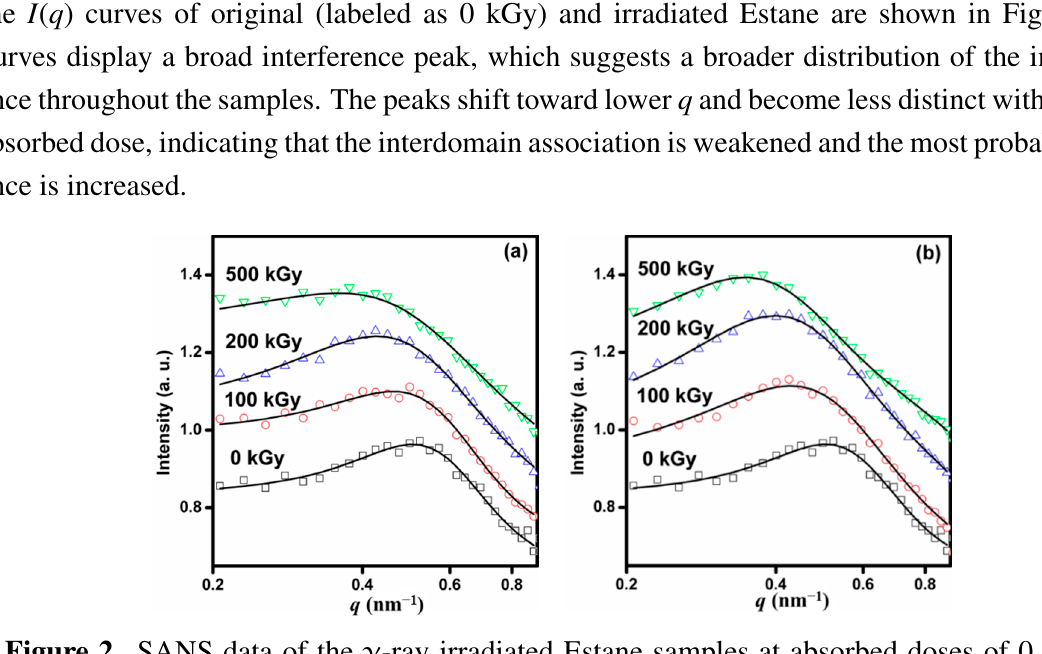
Figure 2. SANS data of the γ -ray irradiated Estane samples at absorbed doses of 0, 100, 200 and 500 kGy in air ( a ) and water ( b ).